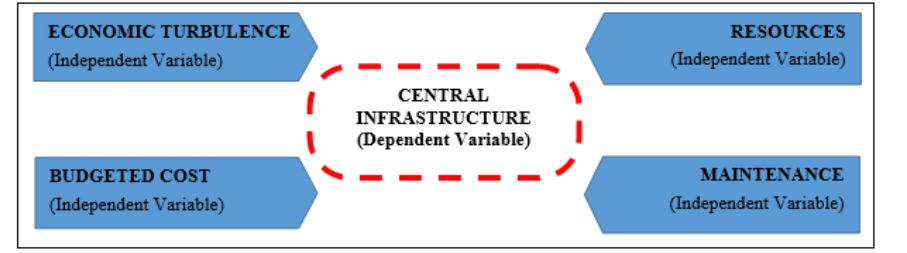
Figure 1. Investigation Concept .